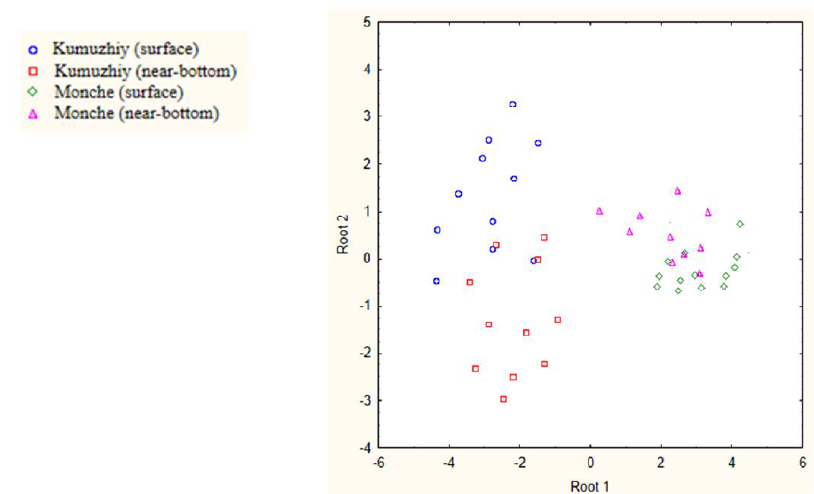
Figure 3. Discriminant analysis results for selected points. Water 2020 , 12 , x FOR PEER REVIEW